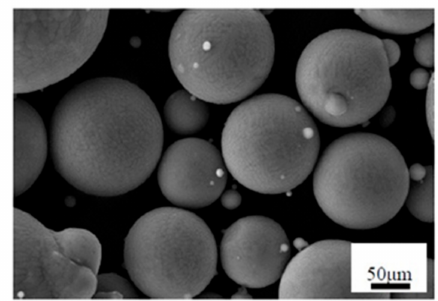
Figure 1. SEM morphology of AA6061 powder.